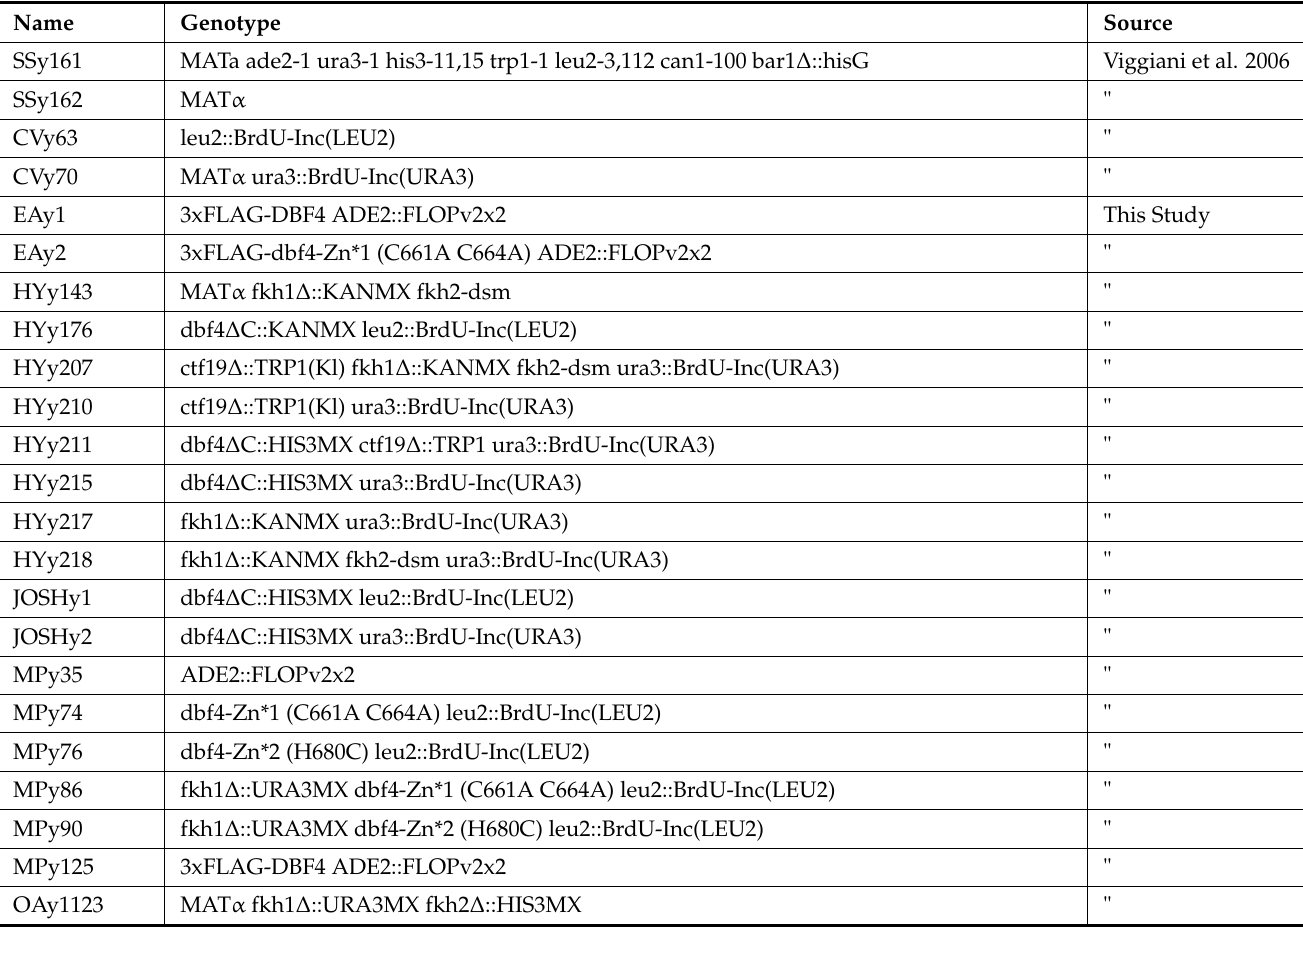
Table 2. Genotypes of S. cerevisiae strains used in this study. All strains are in the W303 ( RAD5 ) background; the parental genotype of SSy161 is shown, whereas for other strains, only differences from this genotype are given.